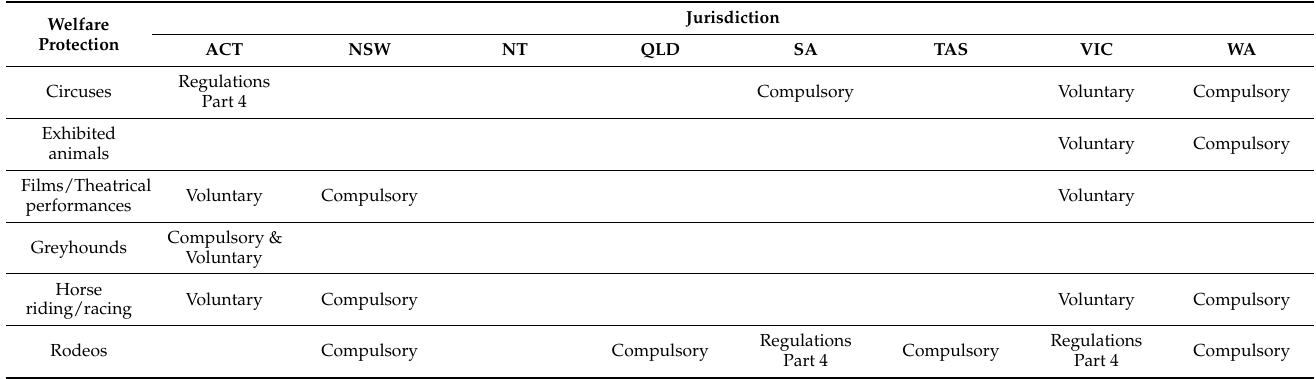
Table 6. Areas of welfare protection assigned to animals used for human entertainment via subor- dinate legislation in each Australian jurisdiction. The terms ‘compulsory’ and ‘voluntary’ refer to the status of the code of practice. For a detailed list of all compulsory and voluntary codes, refer to, Appendices A and B respectively. This table is not intended to be an exhaustive list of all areas of entertainment animal protection, just of those areas that were identified from the search